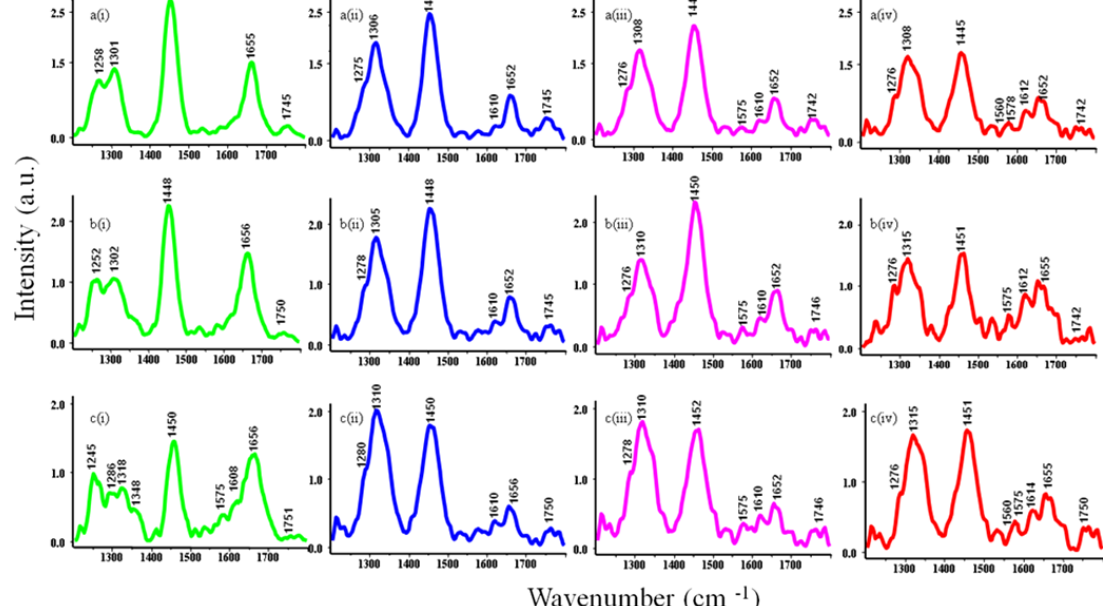
Fig. 3. Average spectra for subsites (a) Buccal mucosa, (b) Lip, (c) Tongue in (i) healthy (green), (ii) contralateral (blue), (iii) premalignant (pink) and (iv) tumor (red)